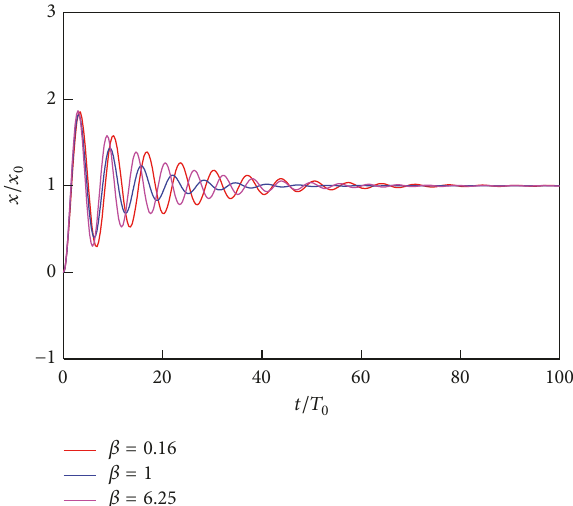
Figure 20: Response in the time domain (𝛼 = 1.2, 𝛽 = 0.16, 1, 6.25)